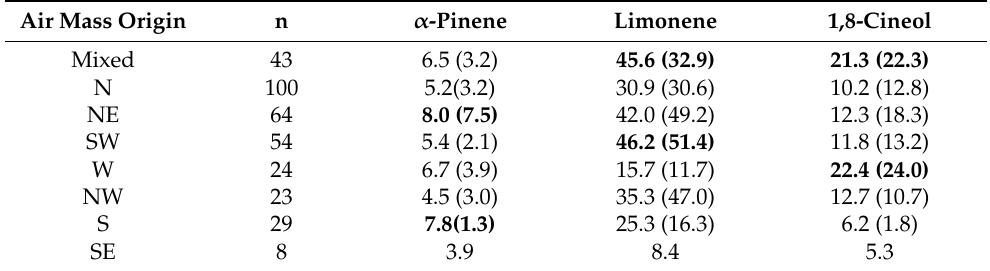
Table 4. Average monoterpene mixing ratios (standard deviation in parentheses) for each air mass sector; n is the number of samples per sector. The two largest mean mixing ratios are marked in